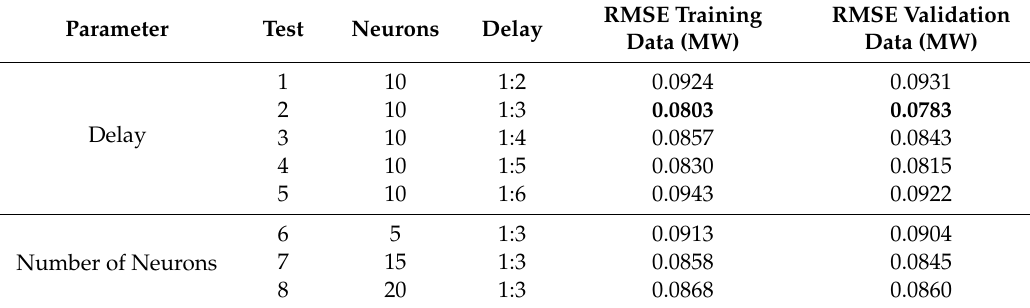
Table 5. Structure design test for option